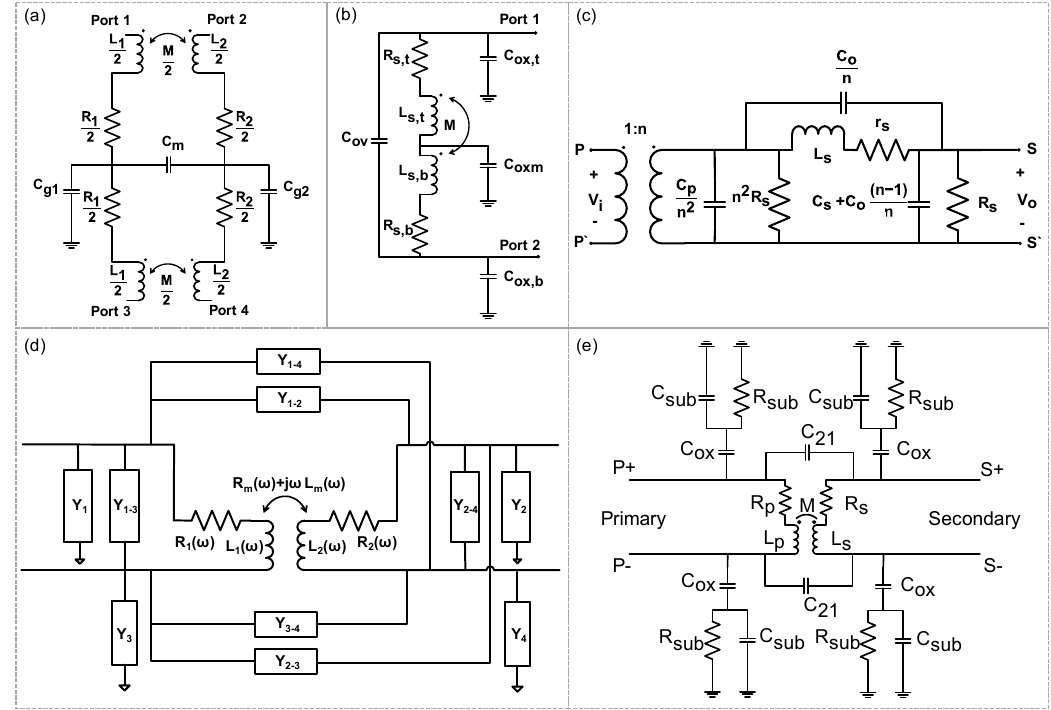
Figure 1. Some examples of earlier circuit models for on-chip transformers, including: ( a , b ) Lumped models [15,18] and ( c ) a high frequency model with primary side referred to the secondary [4]. Examples of frequency-dependent on-chip transformer models: ( d ) A compact frequency-dependent model [38]; ( e ) a frequency-dependent model with less error [30].